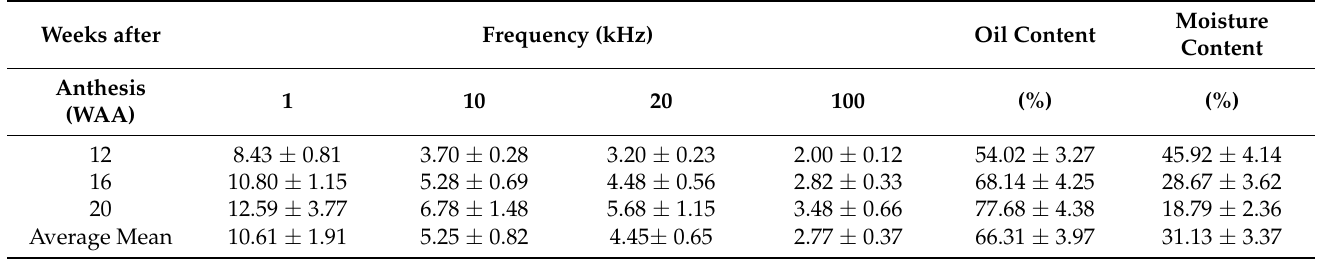
Table 3. Summary of impedance measurements at four frequency levels and the oil palm fruitlets’ properties at three different maturity stages.